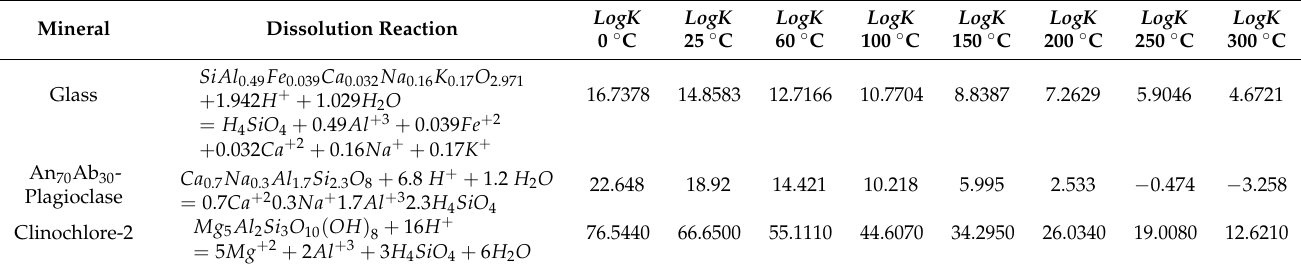
Table 6. Dissolution reactions and equilibrium constants ( LogK ) of solid phases added to the THERMODDEM database. Mineral Dissolution